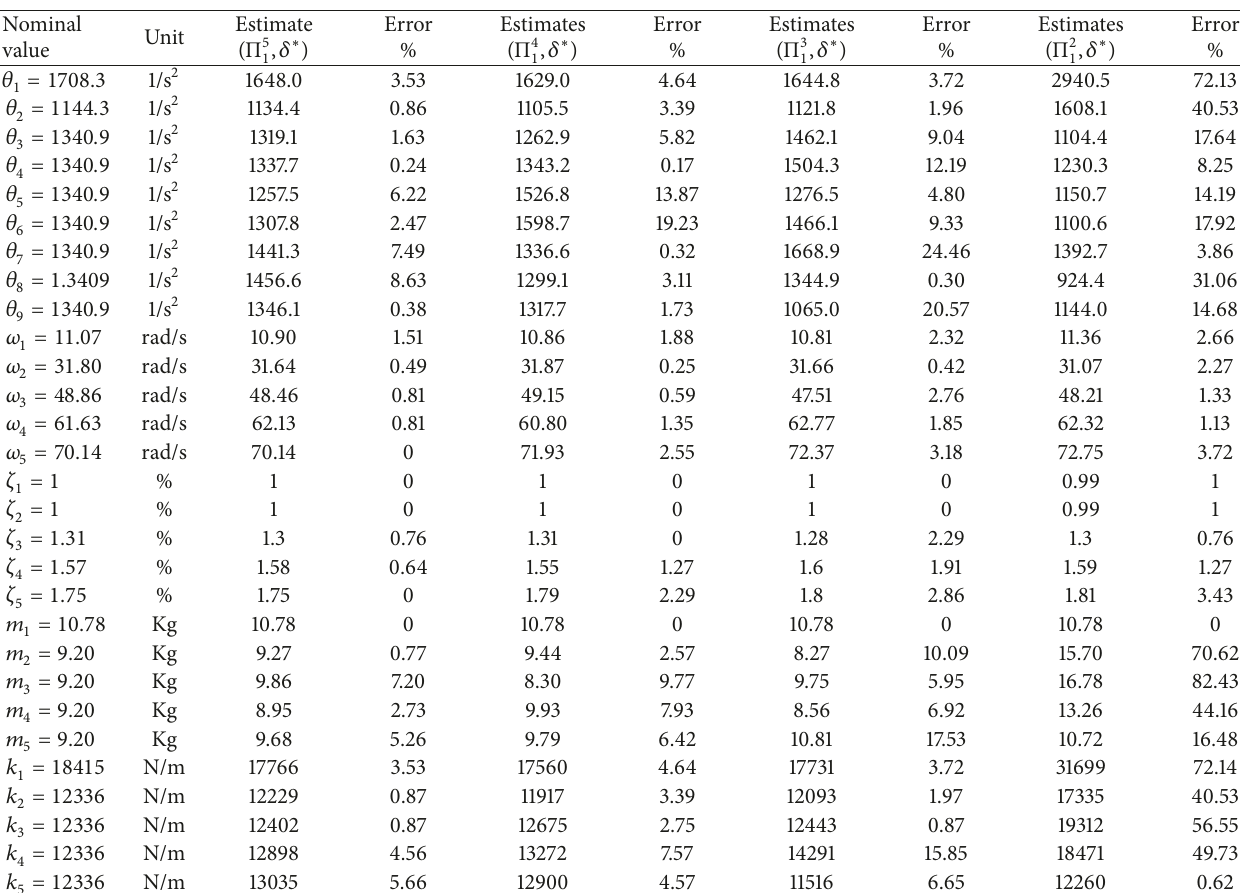
Table 6: Parameter estimates corresponding to the distributions Π 2 1 , Π 3 1 , Π 4 1 , and Π 5 1 of two, three, four, and five